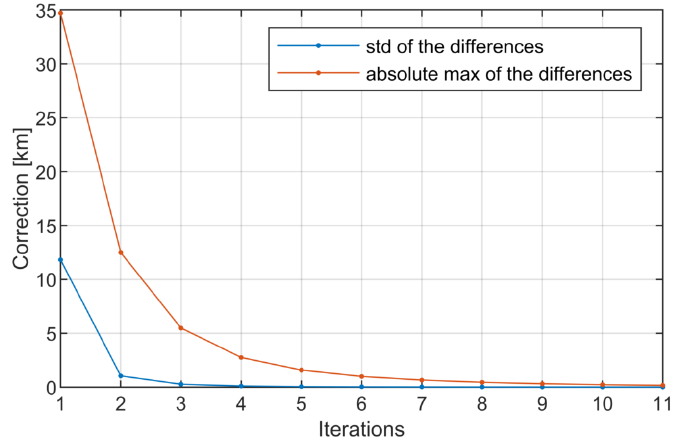
Figure 9. Statistics (standard deviation in blue and maximum of the absolute value in red) of the Moho depth differences between an iteration and the previous one, showing the convergence of the algorithm for the s2a case ( δ R 0 ( ϑ , λ ) = 0 ∀ ( ϑ , λ ) ).